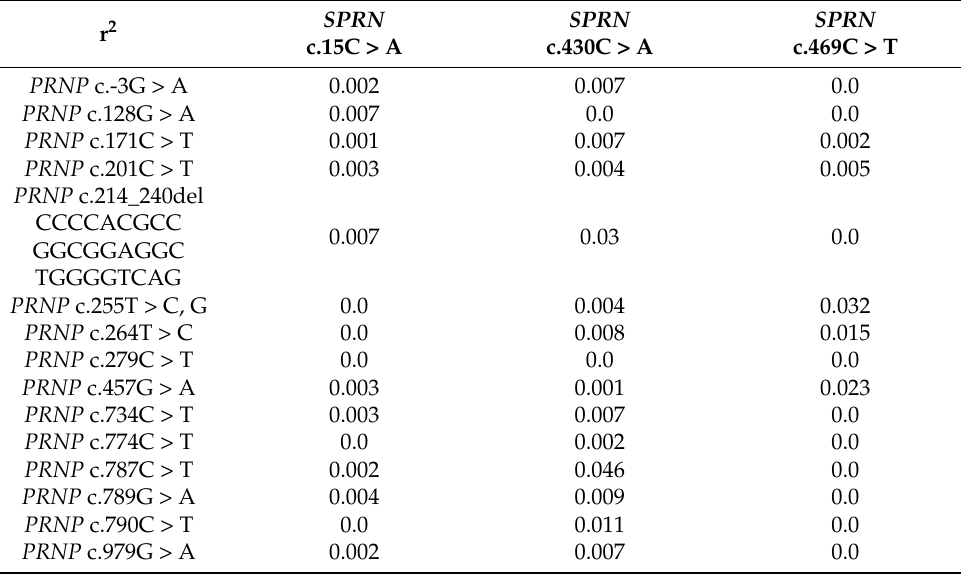
Table 4. LD between polymorphisms in the PRNP and SPRN genes with r 2 values in